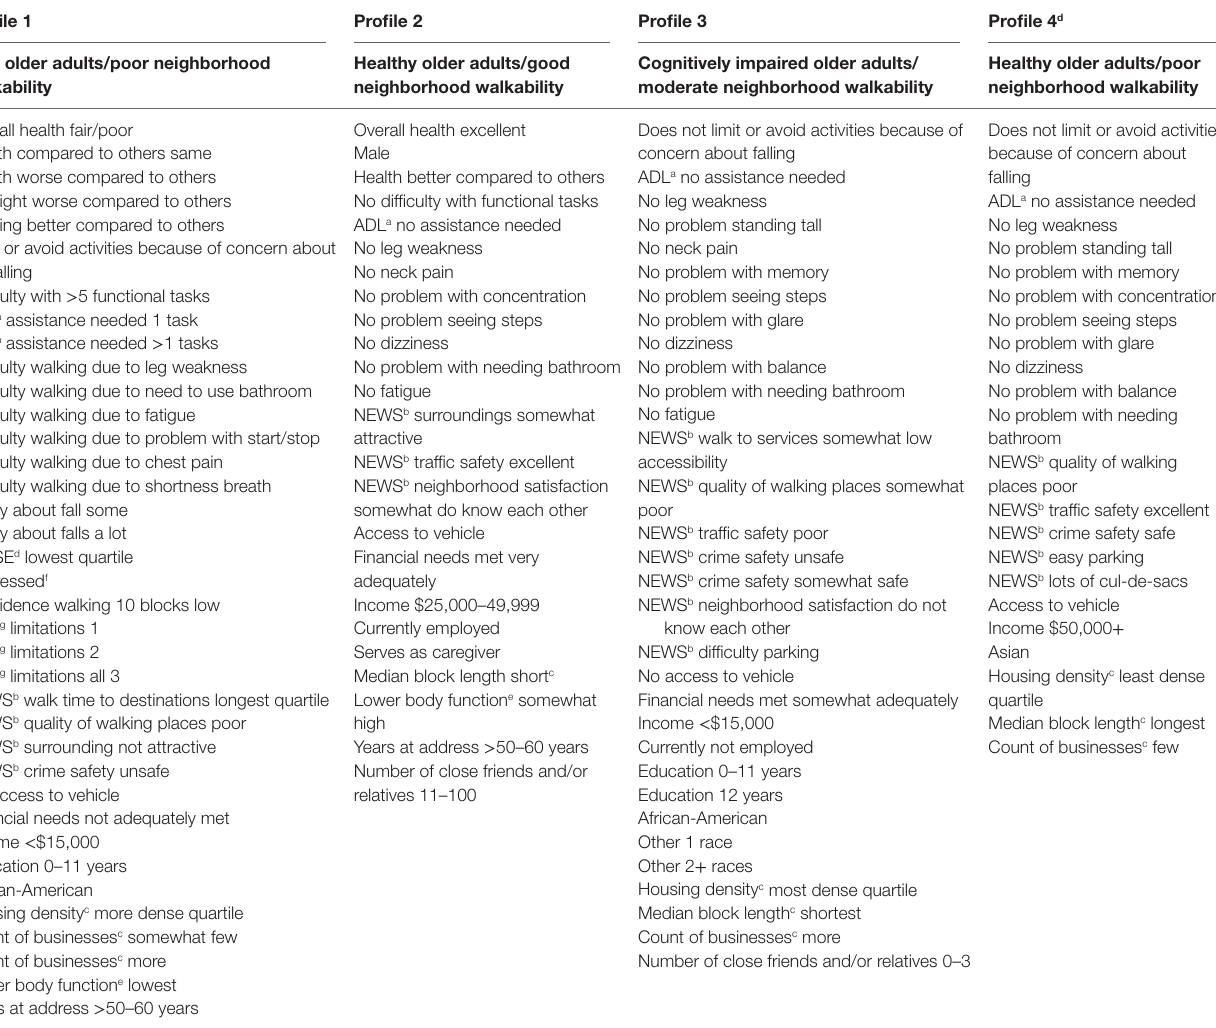
TaBle 2 | A summary of the distinguishing categories for the individual and environmental variables by